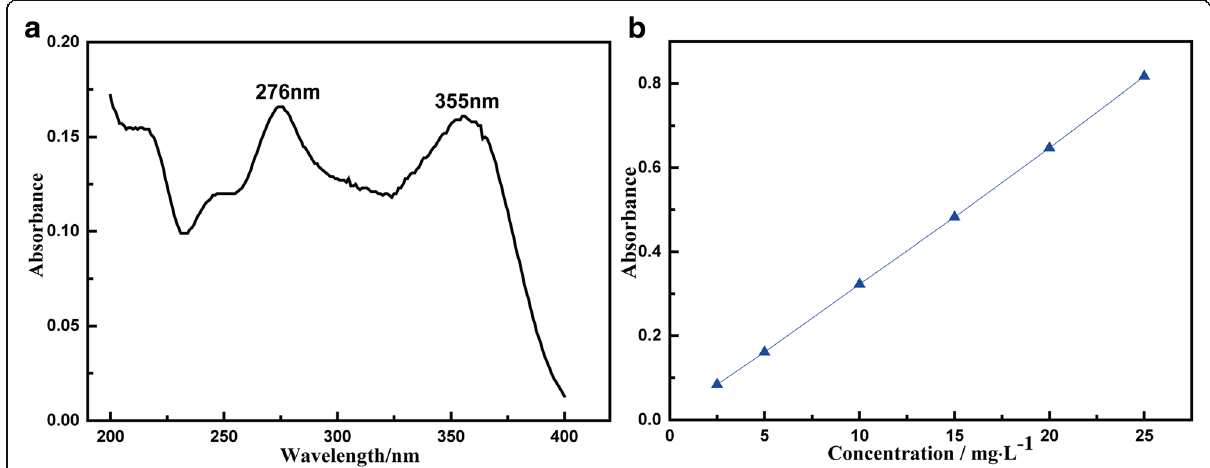
Fig. 1 a UV spectrum and ( b ) calibrated curve for measurement of the concentration of